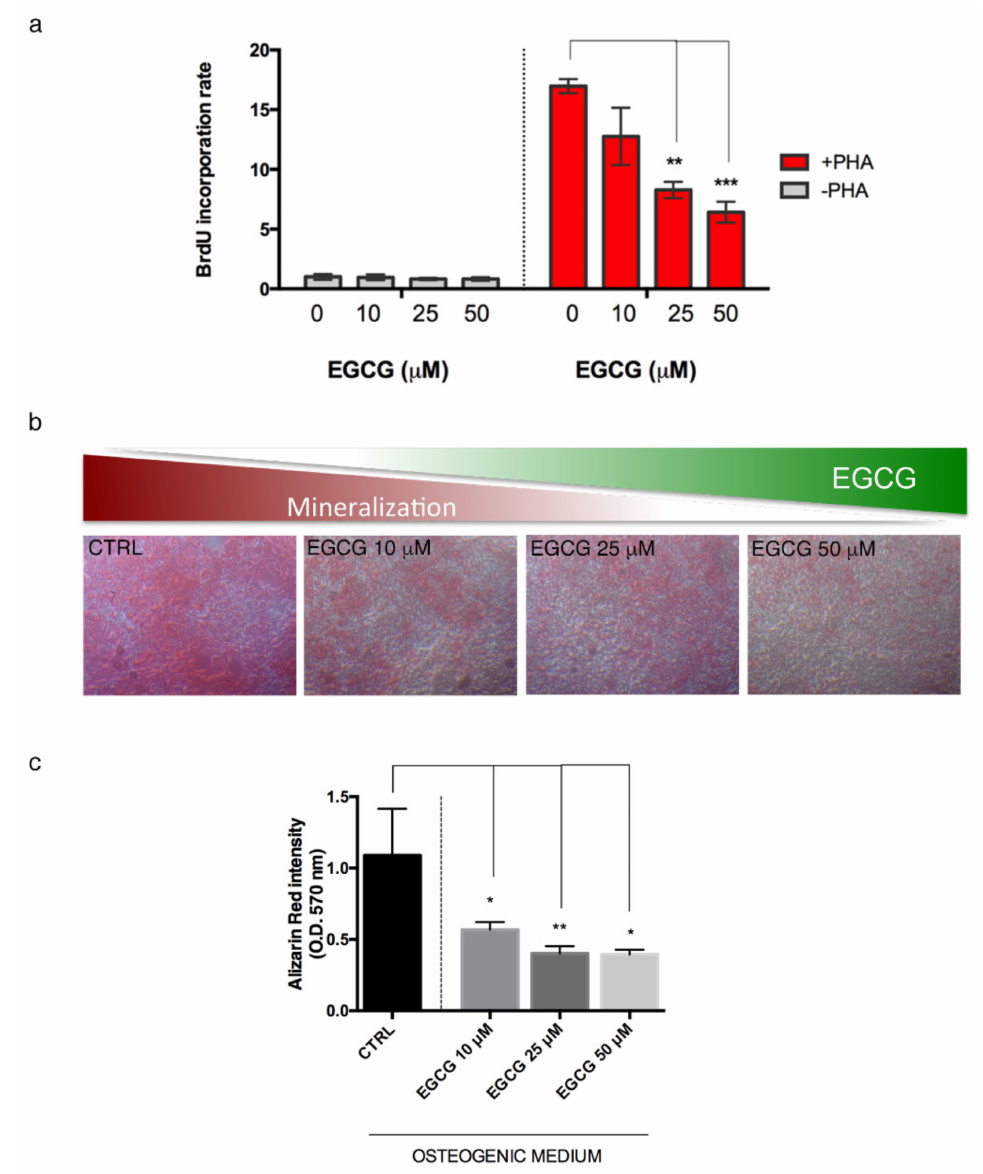
Figure 4. EGCG affects PBMCs proliferation and HUVEC osteogenic potential. ( a ) Analysis of Brdu incorporation rate in human PBMCs activated with PHA and treated with EGCG. Statistical analysis was performed by one-way ordinary Anova, followed by Sidak multiple comparison tests; **, p < 0.01; ***, p < 0.001. ( b ) Mineralization assay (10 × magnification) and ( c ) Alizarin Red relative quantification, in HUVEC grown in osteogenic differentiation medium, and treated with EGCG. Images are representative of three independent experiments. Statistical analysis was performed by mutiple Student’s t -test; *, p < 0.05; **, p < 0.01. All data in this Figure are expressed as mean ± SD of at least 3 independent experiments. EGCG: epigallo-catechin-3-gallate; PBMCs: peripheral blood mononuclear cells; HUVEC: human umbilical vein endothelial cells; Brdu: